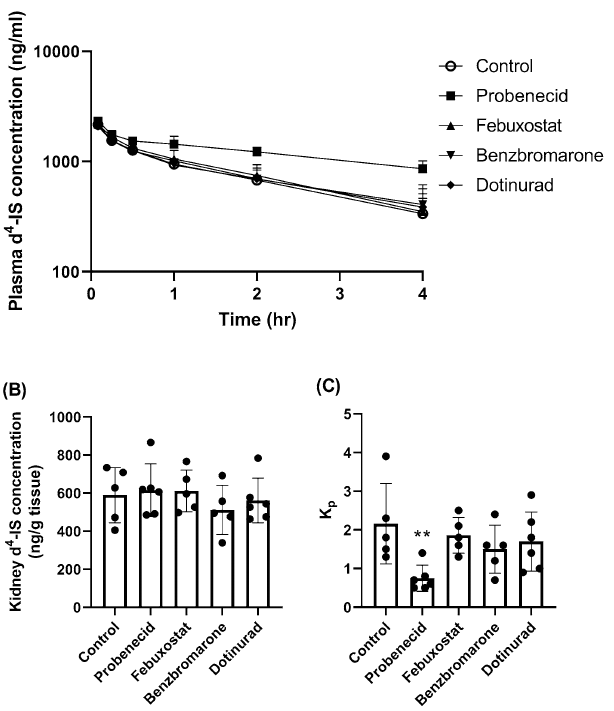
Figure 3. Effect of hypouricemic agents on d 4 -IS concentration in the plasma ( A ) and kidney ( B ), and K p ( C ) in adenine-induced acute renal failure rats. IS: indoxyl sulfate, K p : kidney-to-plasma partition coefficient. Hypouricemic agents or their vehicles as controls were orally administered to Wistar rats fasted for 16 h. After 30 min, d 4 -IS was intravenously administered. Blood samples were collected at 0.083, 0.25, 0.5, 1, 2, and 4 h after d 4 -IS administration. Plasma samples were deproteinated, and the d 4 -IS concentrations was measured by LC–MS/MS. Each value is presented as mean + SD ( A ) or mean ± SD with individual dots ( B and C ) of five to six animals. **: P < 0.01, significantly different from the control group according to Dunnett’s multiple comparison test.